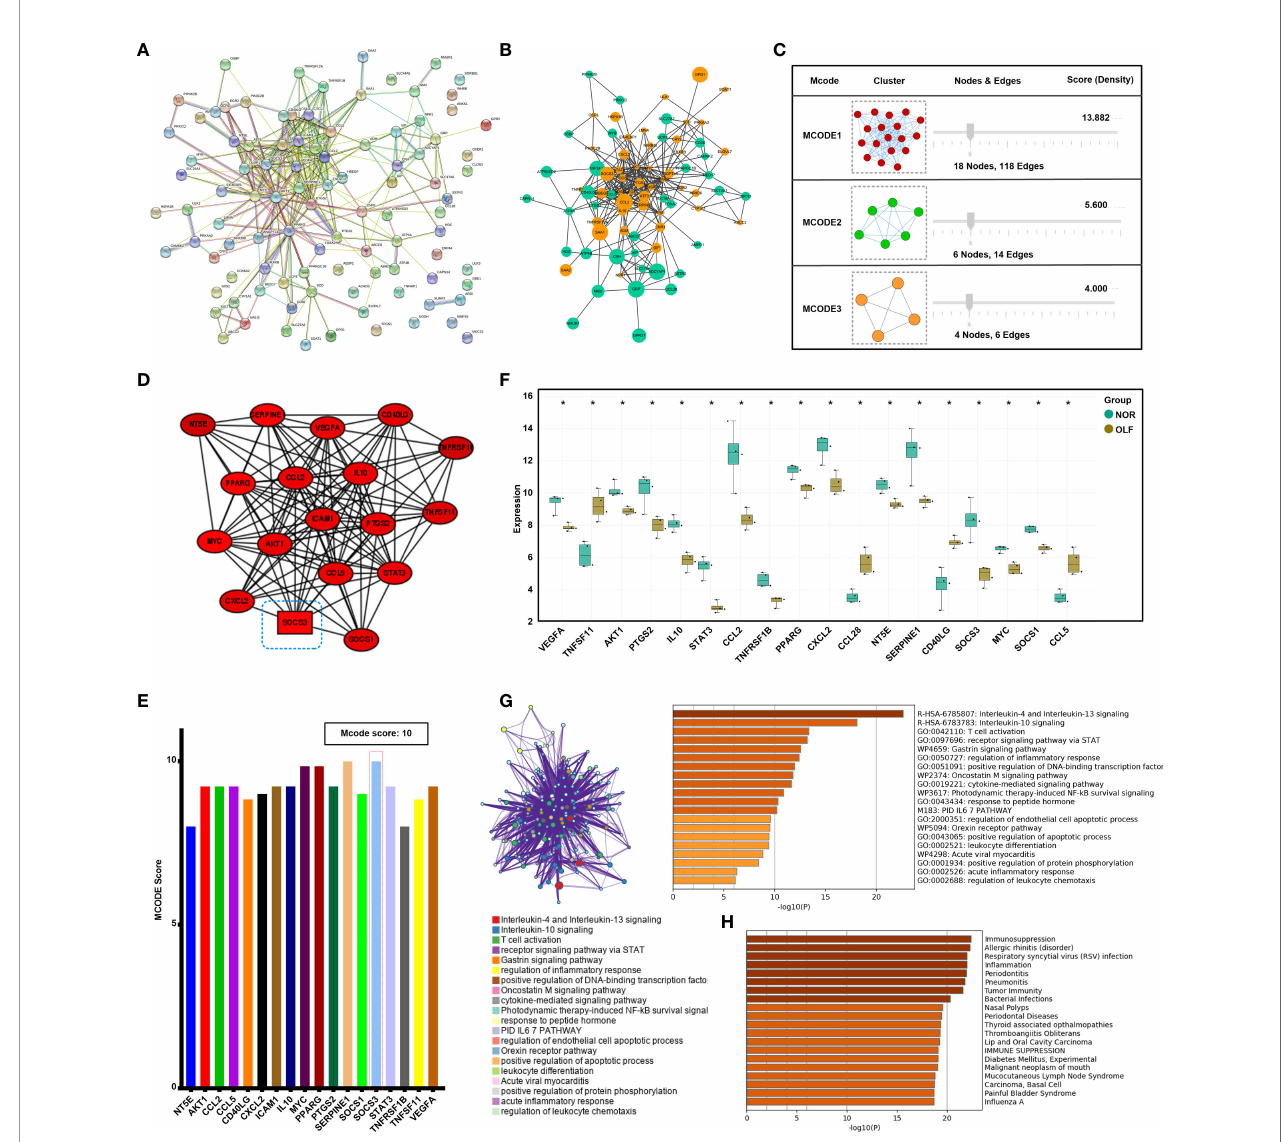
FIGURE 4 | Protein-protein interaction network construction and modular analysis. (A) Construction of the PPI network based on all 99 ORDEGs in STRING 11.5. (B) The PPI network of these ORDEGs was displayed in the Cytoscape software. Up-regulated genes are marked in light green; down-regulated genes are marked in light orange. (C) Three signi fi cant modules from the PPI network were extracted by MCODE analysis. (D) The most highly connected sub-network (cluster rank 1; Score 13.882) identi fi ed by module analysis included 18 nodes and 118 interactions. (E) Connection scores of all genes in the leading cluster. (F) Box plot displayed the expression of all genes in the leading clusters; *p < 0.05. (G) Metascape functional annotation for hub genes in the leading cluster. (H) Enrichment analysis in DisGeNET for hub genes in the leading